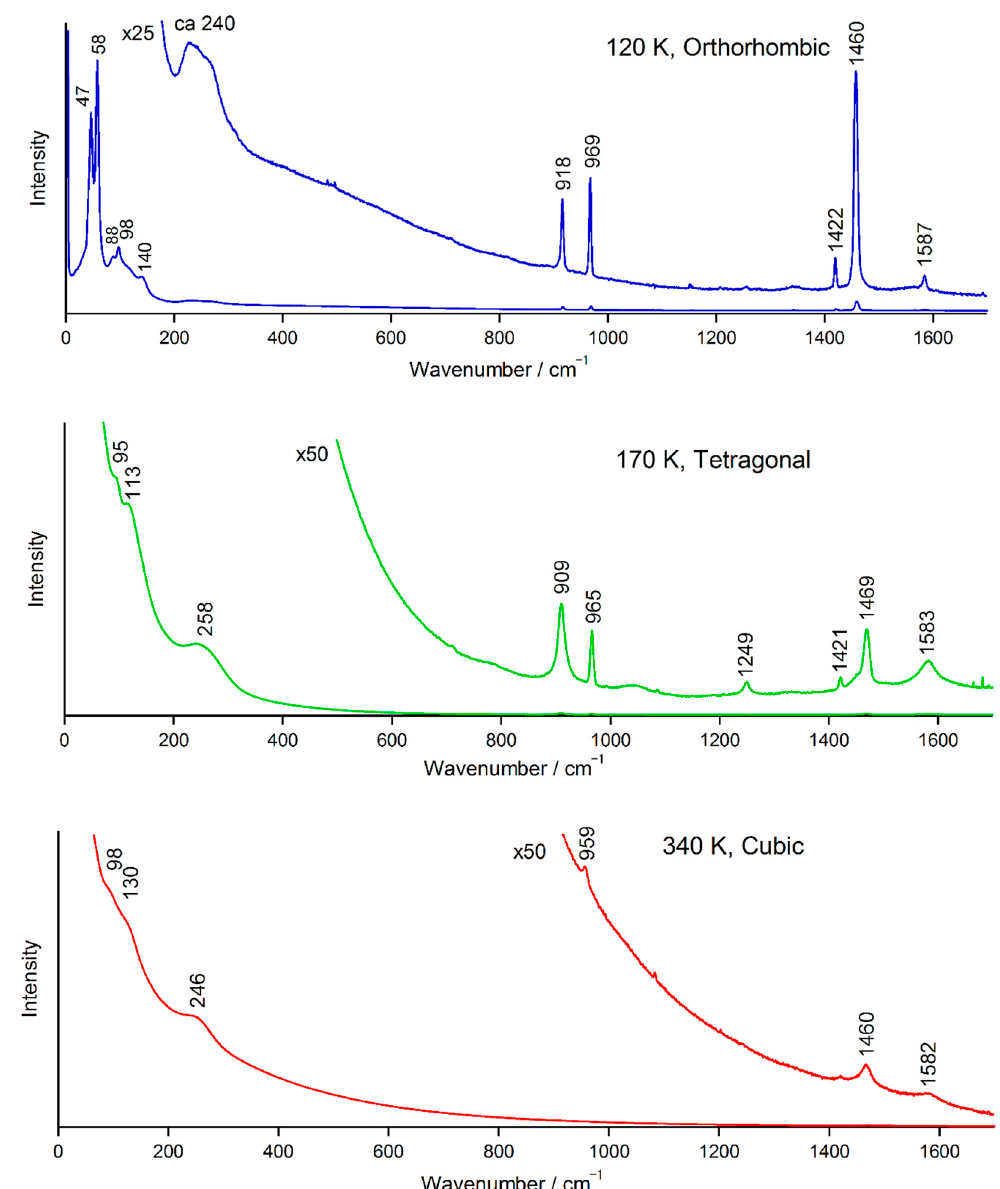
Figure 3. Raman spectra of a MAPbI 3 pellet; excitation wavelength: 830 nm.